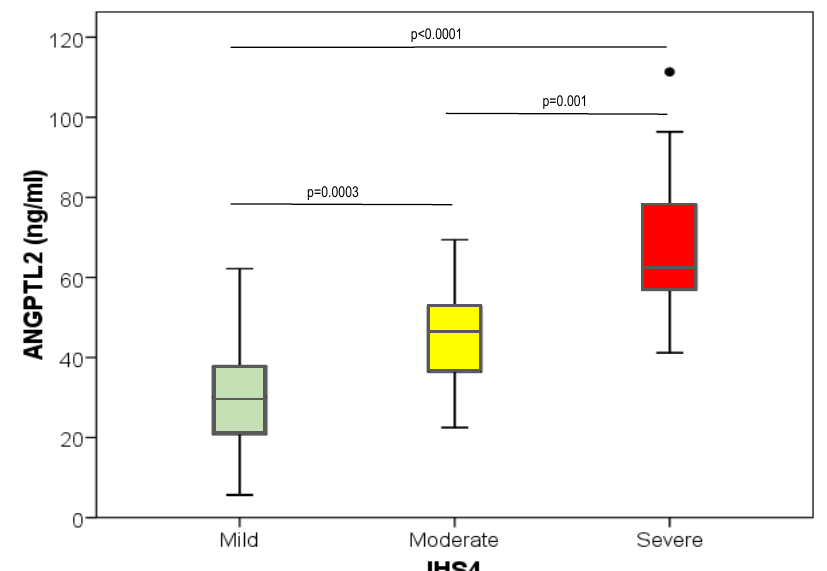
Figure 2. Box and whisker plot representing the serum ANGPTL2 levels in the different HS patients’ groups, according to the HS patients’ severity score (IHS4). Significant differences between groups of patients are shown.